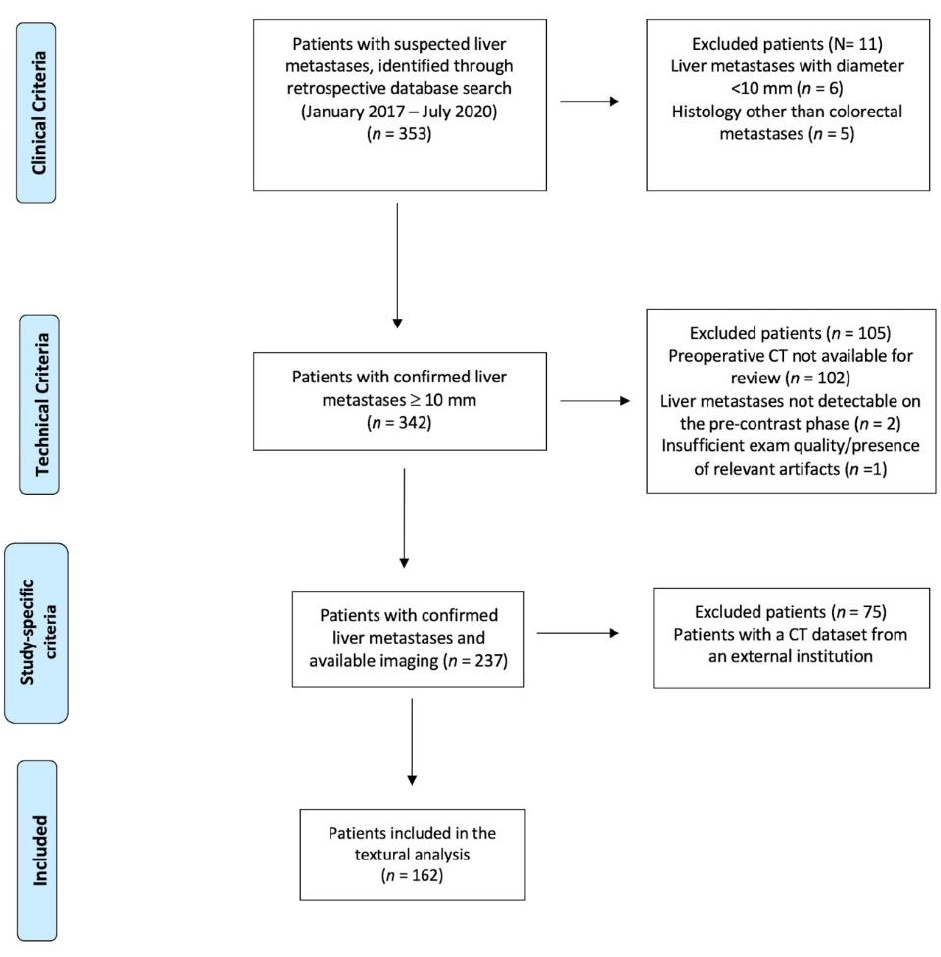
Figure 1. Patients’ inclusion flowchart. Table 1. Characteristics of the studied population.